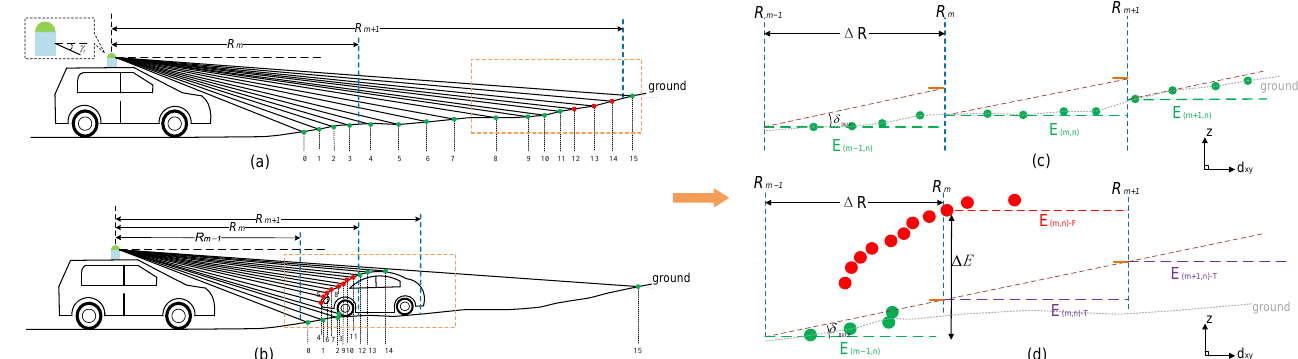
Figure 4. The segmentation results of different ∆ R values and the segmentation principle diagram of the ring-shaped elevation conjunction map (RECM). ( a ) A large value of ∆ R causes under-segmentation. The distant road surface is considered as an obstacle. ( b ) A small value of ∆ R causes over-segmentation. The car’s roof is regarded as the ground. ( c ) Points on the slope are corrected to the ground by the RECM. ( d ) Points on the roof are corrected to the obstacles by the